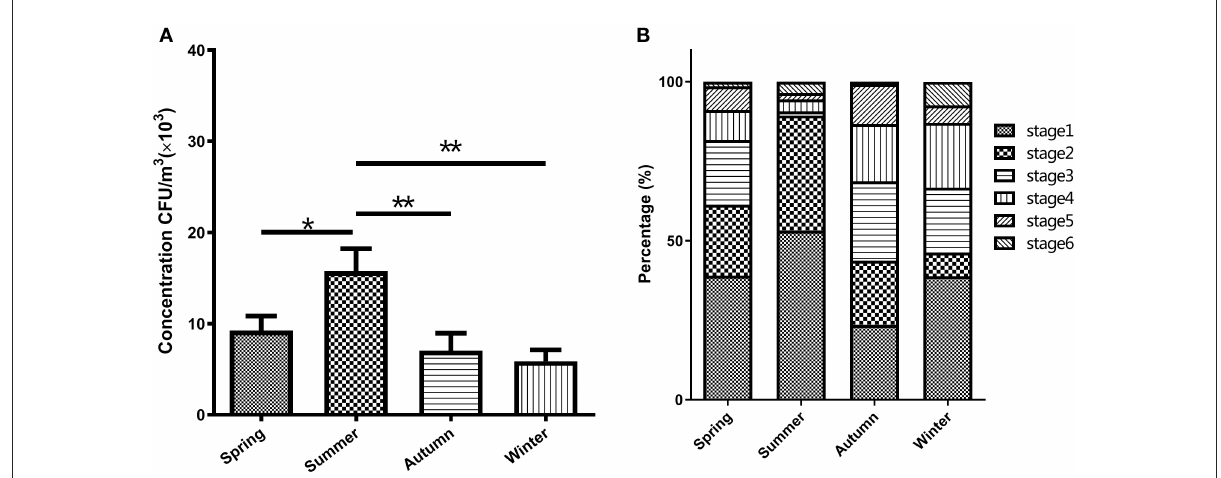
FIGURE1 Characteristics of the airborne bacterial aerosol concentration in the broiler house (A) and size distribution of airborne cultivable- bacterium-containing particles in the broiler house (B) . Size-resolved airborne cultivable bacterial levels were obtained with the Andersen six-stage cascade impactor, expressed as percentages of the total level and categorized into four groups: Spring, Summer, Autumn, and Winter. Aerodynamic diameter ranges for the viable particle sizing sampler were > 7.0 µ m (stage 1), 4.7–7.0 µ m (stage 2), 3.3–4.7 µ m (stage 3),